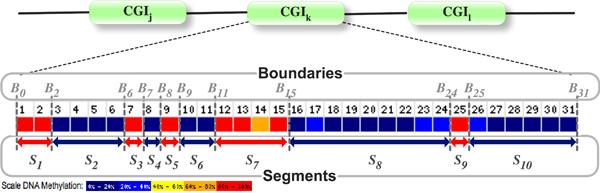
Illustration of the initial segment definition. Because all boundary variables are set to 1, 10 initial segments are defined. Later, the segment modeling algorithm considers alternative segment definition by changing the boundary variable values. Figure was modified from [16,25].